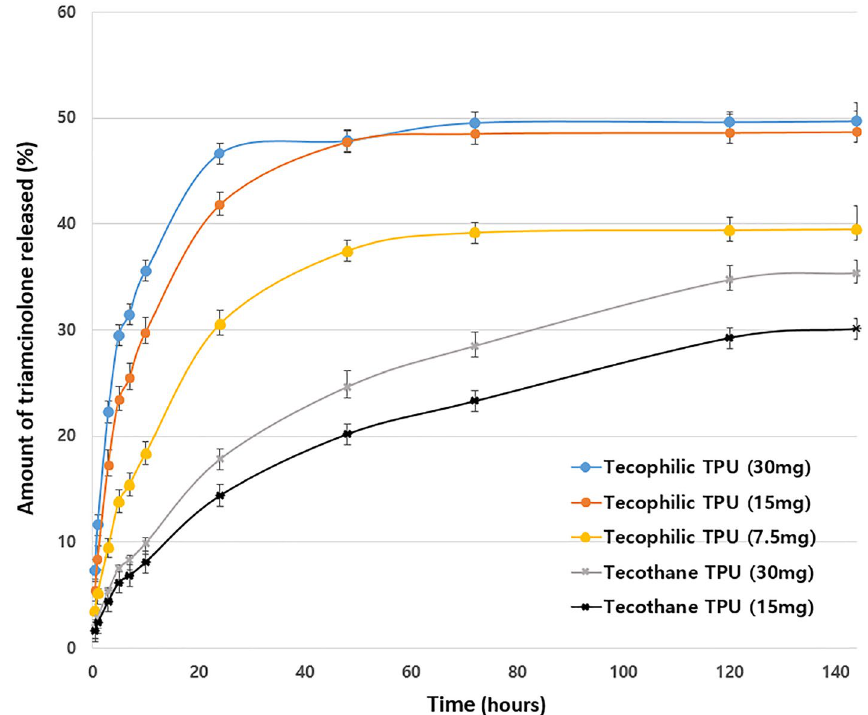
Figure 1. In vitro drug release profile. In vitro cumulative release of triamcinolone over the first 6 days, measured by high-performance liquid chromatography, from experimental stents with various concentrations of triamcinolone and types of